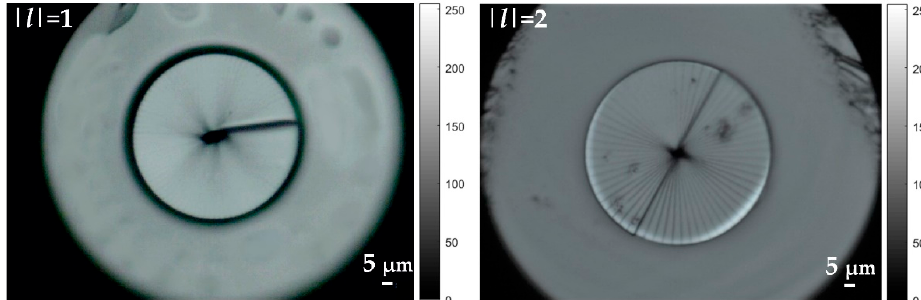
Figure 4. Images of SPP printed on the fiber end